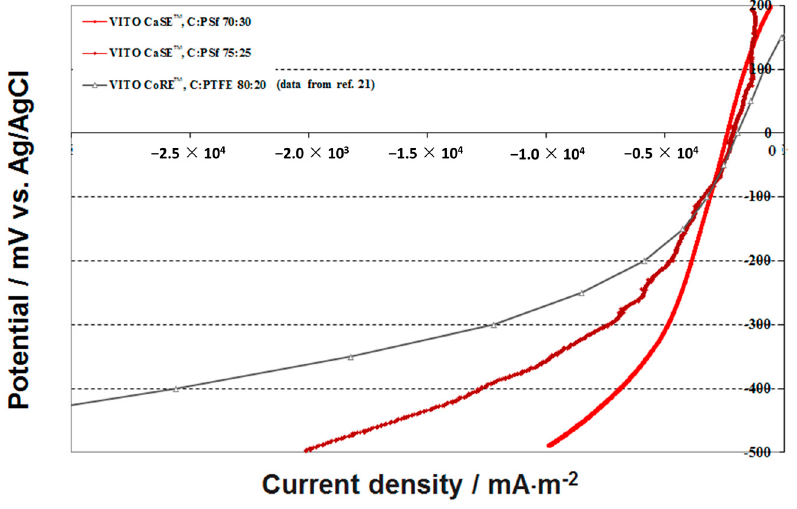
Figure 4. Effect of the composition of the AL (C wt %) on the performance of the VITO CaSE™